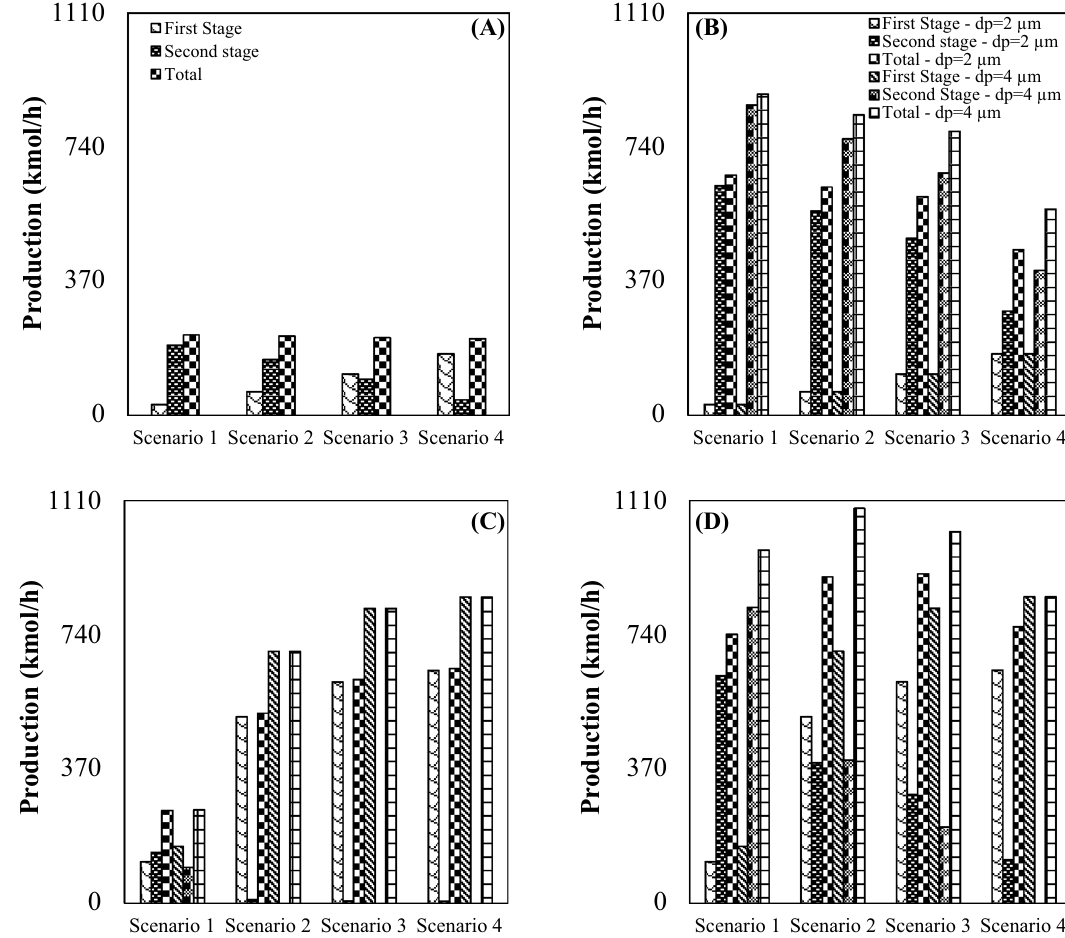
Figure 8. NGL recovery rate for various scenarios, droplet diameter and configurations: ( A ) configuration ( A, B ) configuration ( B, C ) configuration ( C and D ) configuration ( D